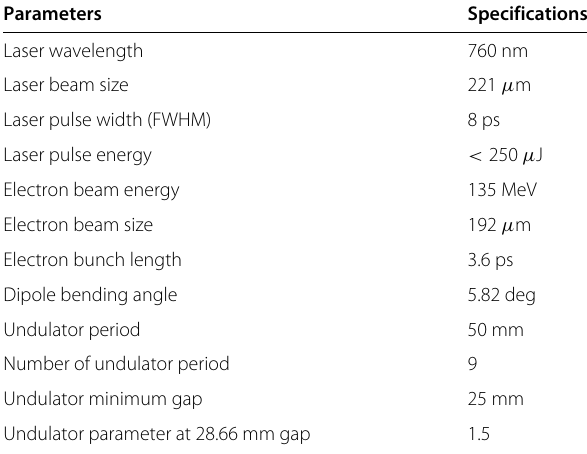
Table 3 Specifications of the PAL-XFEL laser heater